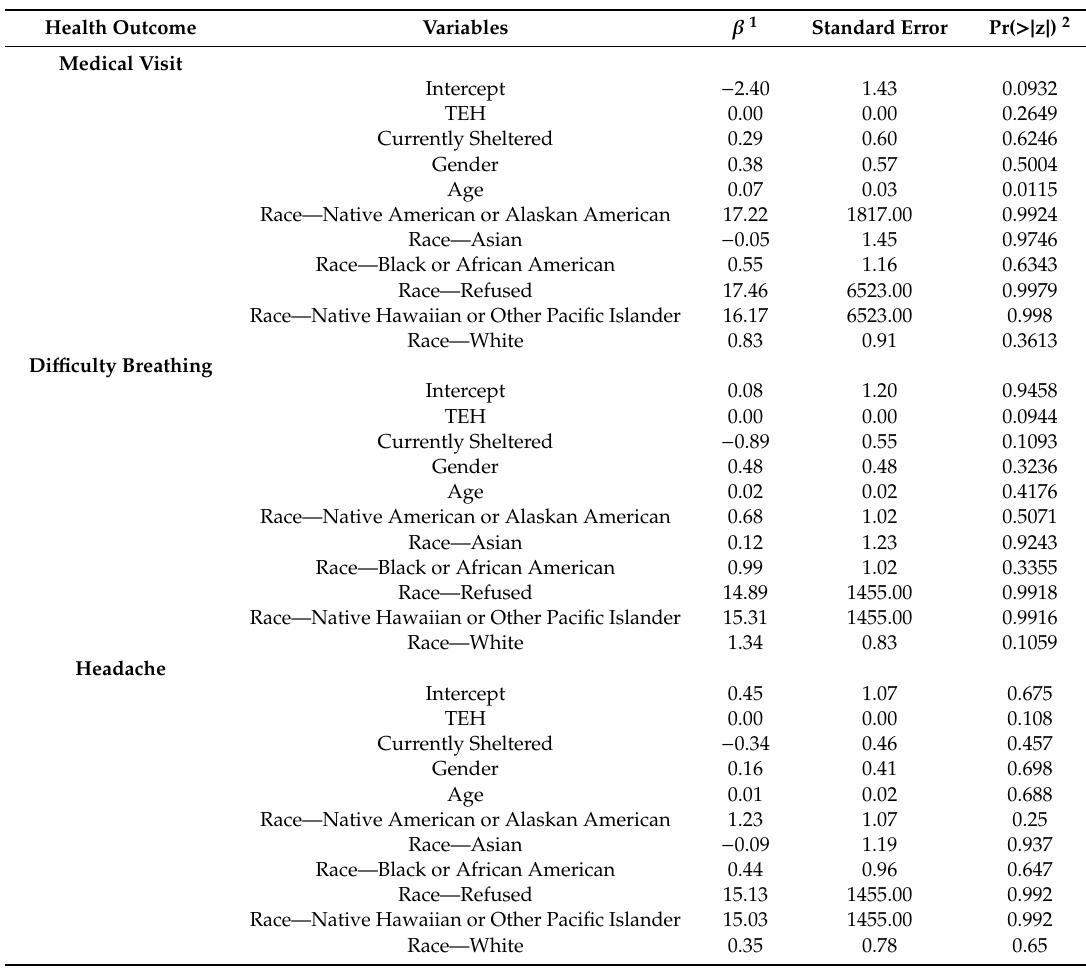
Table A1. Logistic regression results for health